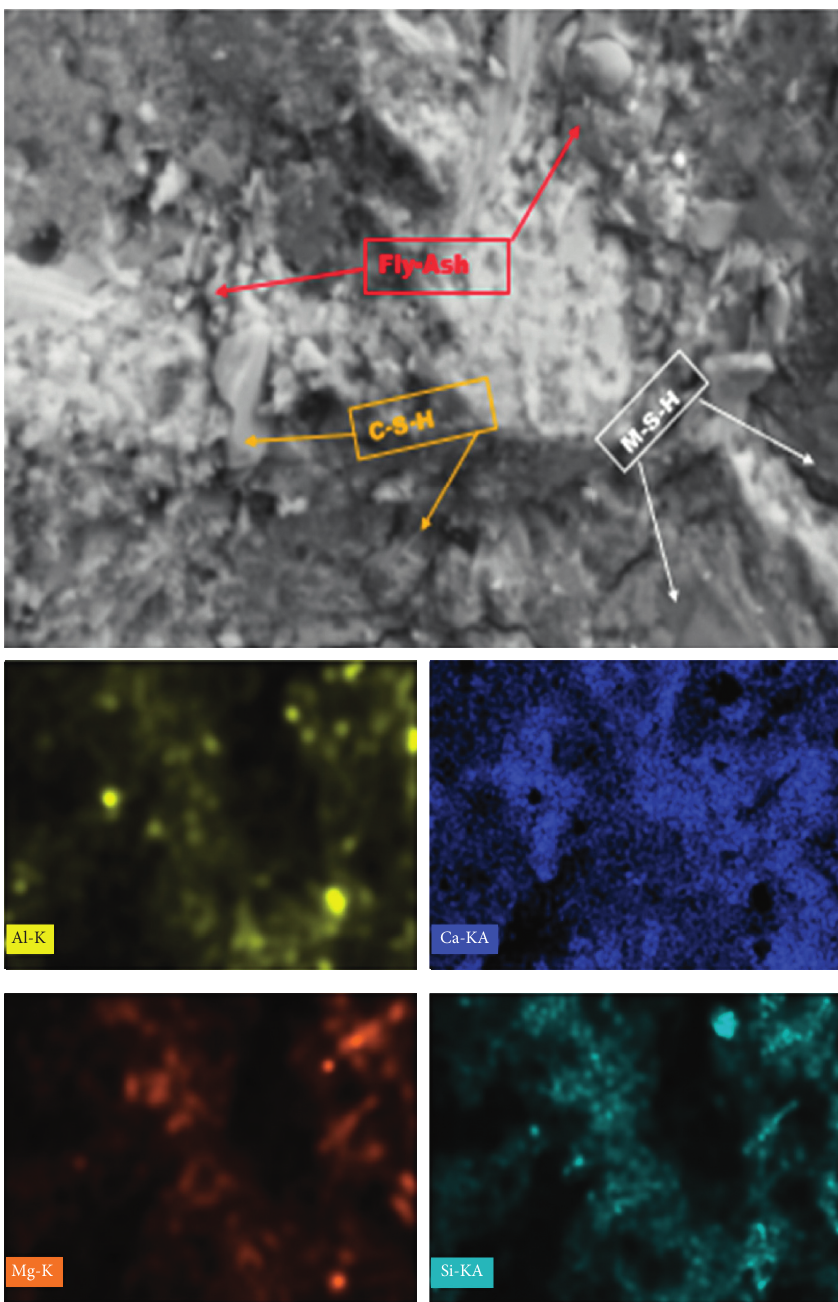
Figure 13: SEM image and corresponding EDX mapping for Al, Ca, Mg, and Si in